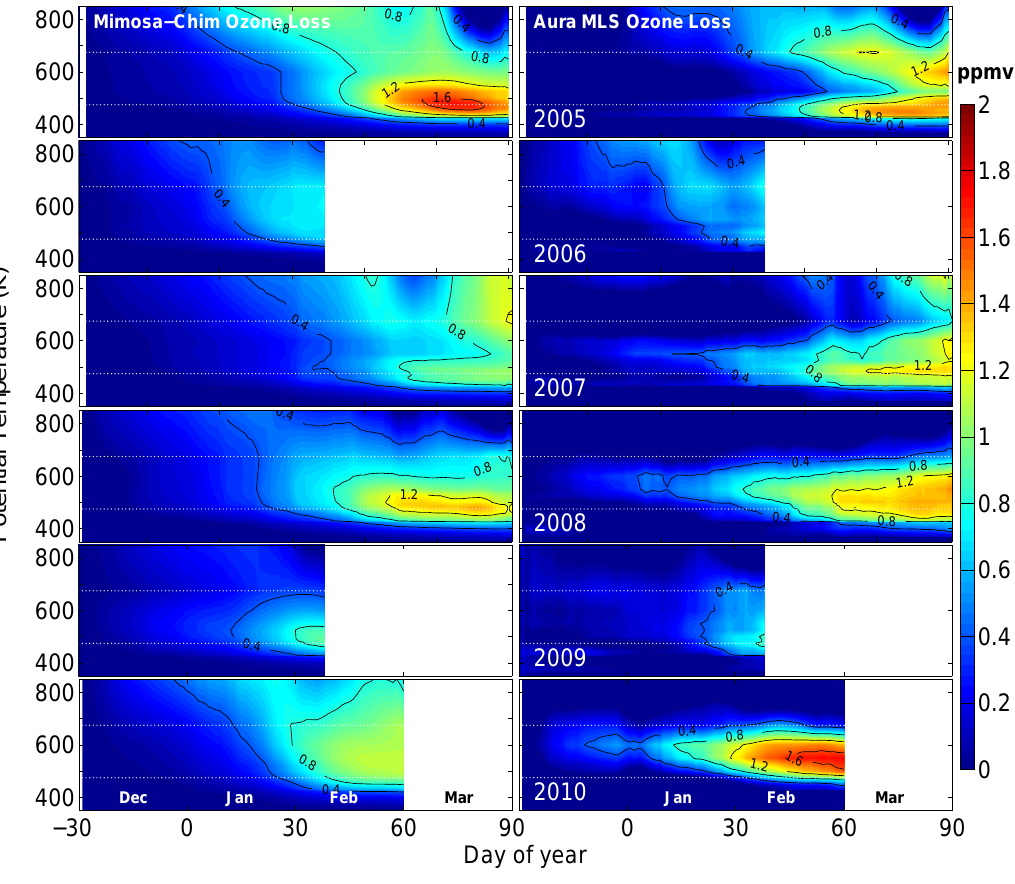
Fig. 4. Temporal evolution of the vertical distribution (350–850K) of vortex averaged ( ≥ 65 ◦ EqL) ozone loss (ppmv) estimated for the Arctic winters 2005–2010. Left: the ozone loss derived from the difference between the passive tracer and the chemically integrated ozone by Mimosa-Chim. Right: the ozone loss derived from the difference between the Mimosa-Chim passive tracer and the ozone measured by MLS. The model fields are sampled at location of the MLS observations. Due to early vortex dissipation caused by the major warmings, the analysis does not extend beyond 10 February in 2006 and 2009. The ozone loss analysis in March 2010 are not included here because of very weak vortex and due to the tracer uncertainties after the major warming. Both data are smoothed for seven days. The white dotted lines represent the study altitudes 475 and